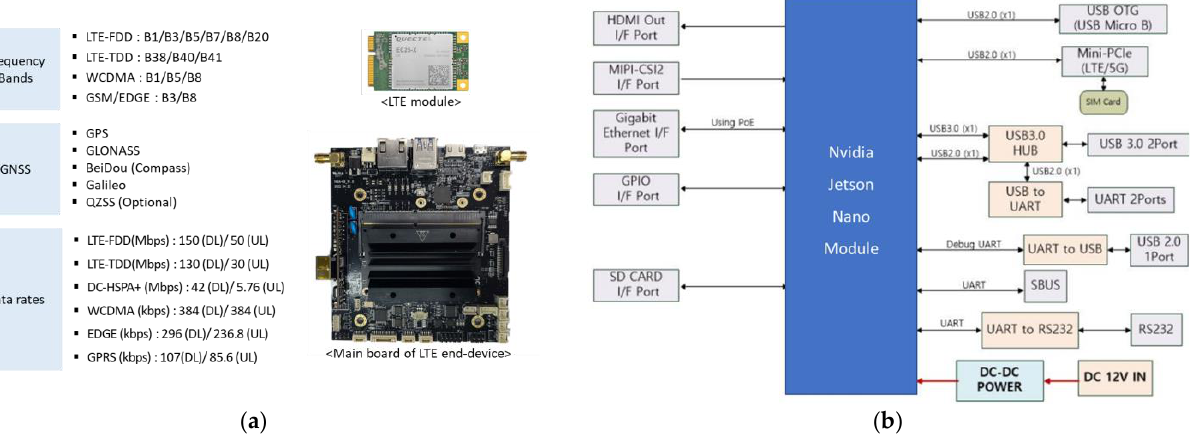
Figure 9. LTE end-device – ( a ) LTE module specification and the main board of LTE end-device; ( b ) Block-diagram of LTE end-device.